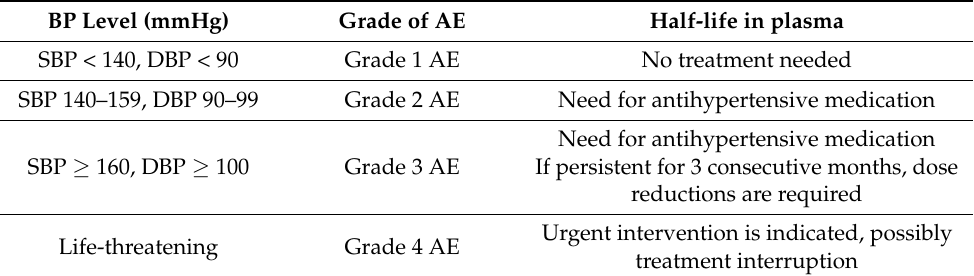
Table 6. Pre-specified treatment plan in